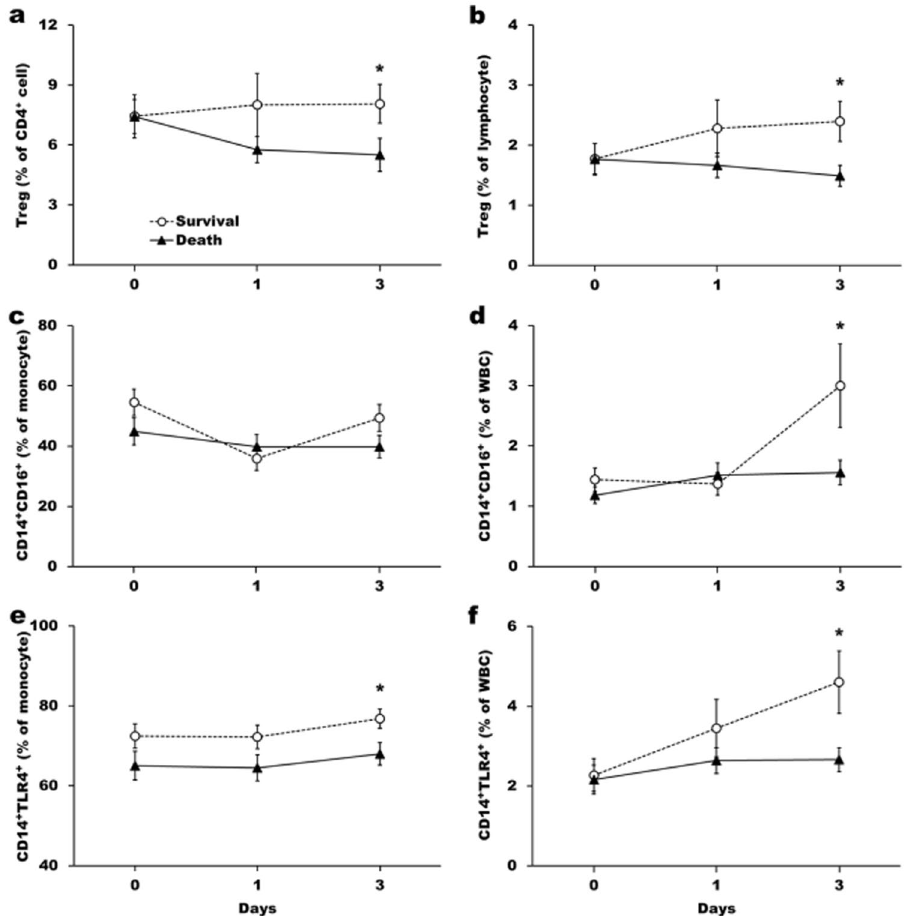
Figure 3. Comparisons of immune cell profiles between survivors and non-survivors in ARDS patients who received ECMO support. T regulator cell percentage in CD4 + lymphocytes ( a ), in total lymphocytes ( b ), CD14 + CD16 + cell percentage in monocytes ( c ), in total white blood cells ( d ), CD14 + TLR4 + cell percentage in monocyte ( e ), and in total white blood cells ( f ) were analyzed at day 0, 1 and 3 during ECMO support and compared between the survival and death groups. The data represented the means and standard errors of each group. Values were logarithmically transformed before bivariate comparisons. * Represents P < 0.05 between death and survival groups.